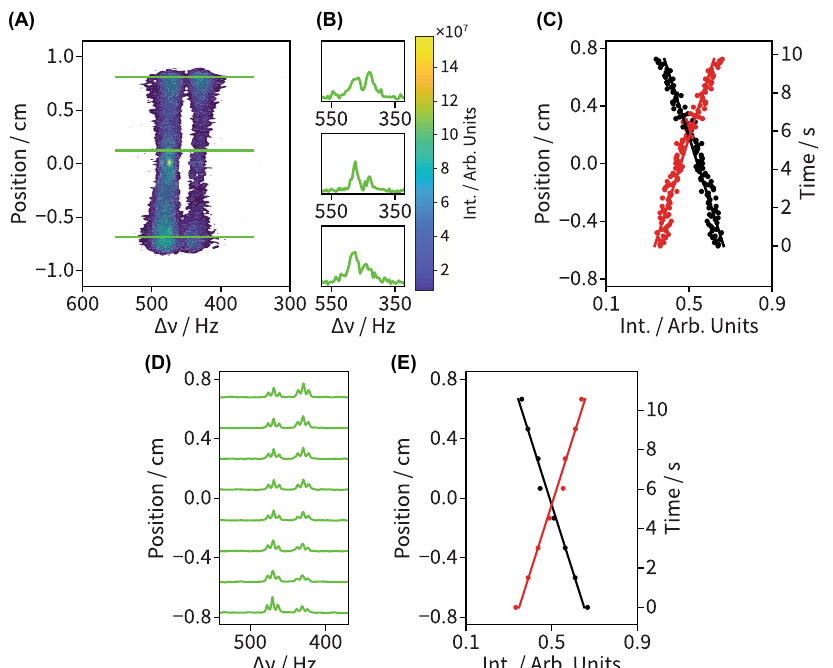
Fig. 4 High-resolution ( Δ t R = 86 ms) time-resolved kinetic NMR spectra of an enzymatically-catalyzed hydrolysis reaction in off-equilibrium. A 1 H EPSI NMR spectrum and B associated spectral cross sections acquired with a reaction-time resolution of Δ t R = 86 ms under conditions of continuous fl ow for a reaction mixture of 25 µ M trypsin and 10 mM BAEE. The following experimental parameters were used in the collection of A : N EPSI = 100, T a = 1 ms, G z = 20.5 G/cm, time-domain data size TD = 80,000 (200 complex pts/echo), and v = 1200 μ m/s (1 mL/min). 240 scans were collected with recycle delay D1 = 5 s. C Integrated signal intensities for the reactant (black circles) and product (red circles) plotted as functions of both position and reaction time against the lines of best fi t from the kinetic analysis (solid lines): k cat = 11.7 s − 1 and t 0 = 11 s. D 1 H slice-selective pulse-acquire NMR spectra acquired at 8 distinct positions across the NMR coil and under similar experimental conditions as those in A – C : 25 µ M trypsin, 10 mM BAEE, and the fl ow